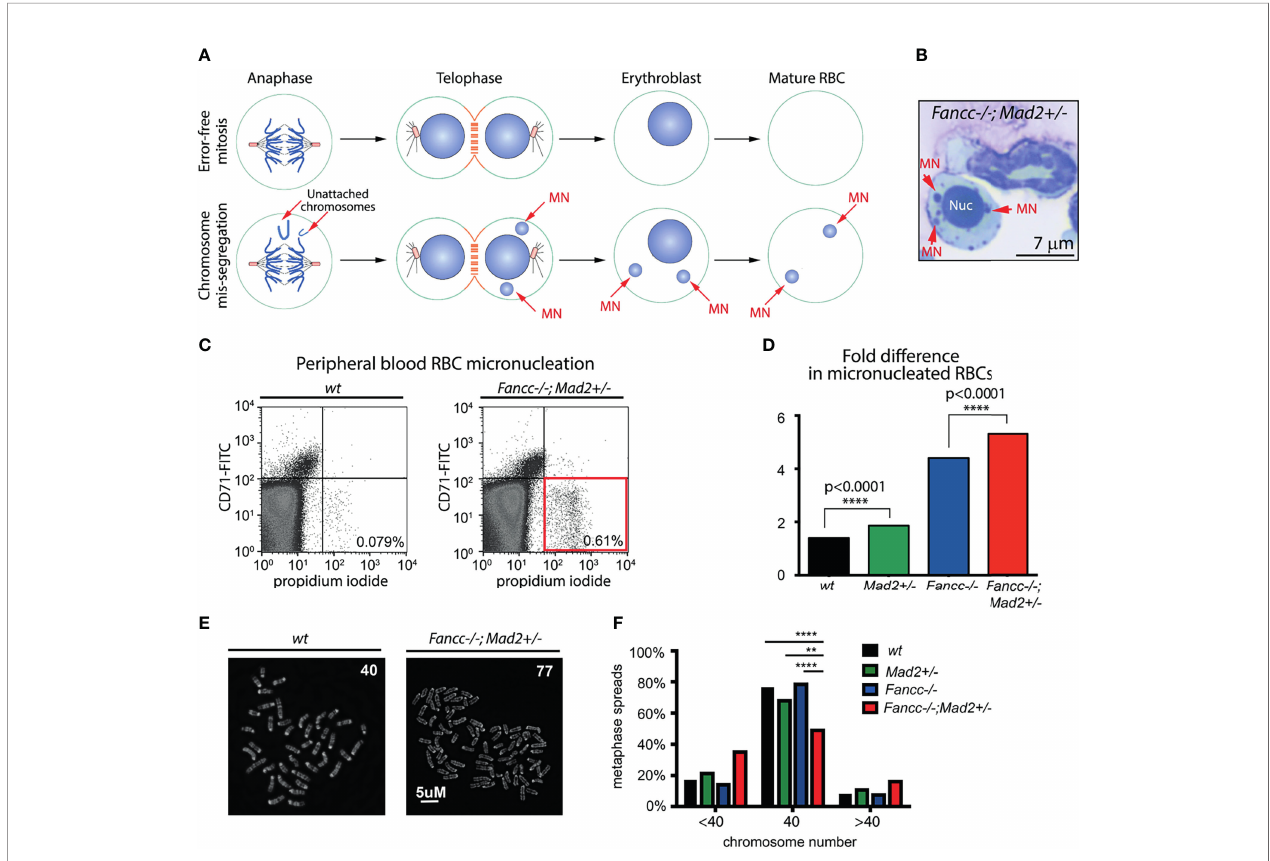
FIGURE 3 | Spontaneous chromosomal instability in Fancc-/-; Mad2+/- mice. (A) Graphic illustrating the rationale of the quantitative red blood cell (RBC) micronucleation fl ow cytometry assay. Unlike normal nuclei, micronuclei (MN) arising from mitotic chromosome mis-segregation are not ef fi ciently removed from maturing erythroblasts and therefore, DNA-positive mature RBCs signify abnormal chromosome sorting during erythropoiesis. (B) Example of a micronucleated cell in Fancc-/-; Mad2+/- bone marrow. Red arrows point to micronuclei (MNs). Nuc, nucleus. (C, D) Flow cytometry demonstrating an increased frequency of chromosome mis-segregation (p<0.0001) during Fancc-/-; Mad2+/- erythropoiesis compared to all other mouse genotypes. CD71 was used as a marker for immature peripheral blood red blood cells (RBCs). Frequencies of DNA-containing mature RBCs (CD71-, propidium iodide+) were statistically compared using Fisher ’ s exact test with n of at least 9 age-matched mice per genotype. (E, F) Karyotype demonstrating genomic instability in non-malignant Fancc-/-;Mad2+/- hematopoietic cells. Normal murine chromosome complement is 40, thus the presence of cells with <40 or >40 chromosomes is suggestive of aneuploidy. Statistical analysis was performed using Fisher ’ s exact test and Bonferroni post-hoc analysis (n=150 metaphase spreads per genotype, ****p < 0.0001, **p =